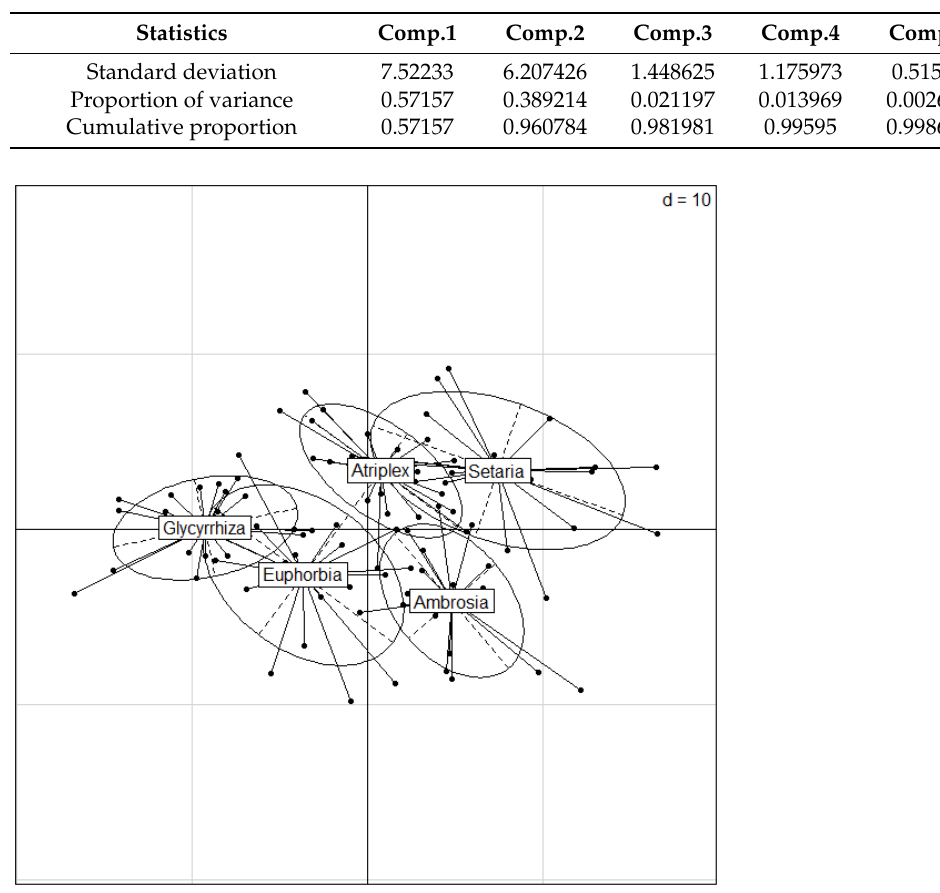
Table 5. The value of the dispersion of the main components of the PCA of the spectral channels for Ambrosia artemisiifolia , Atriplex tatarica , Glycyrrhiza glabra , Euphorbia seguieriana , and Setaria pumila .